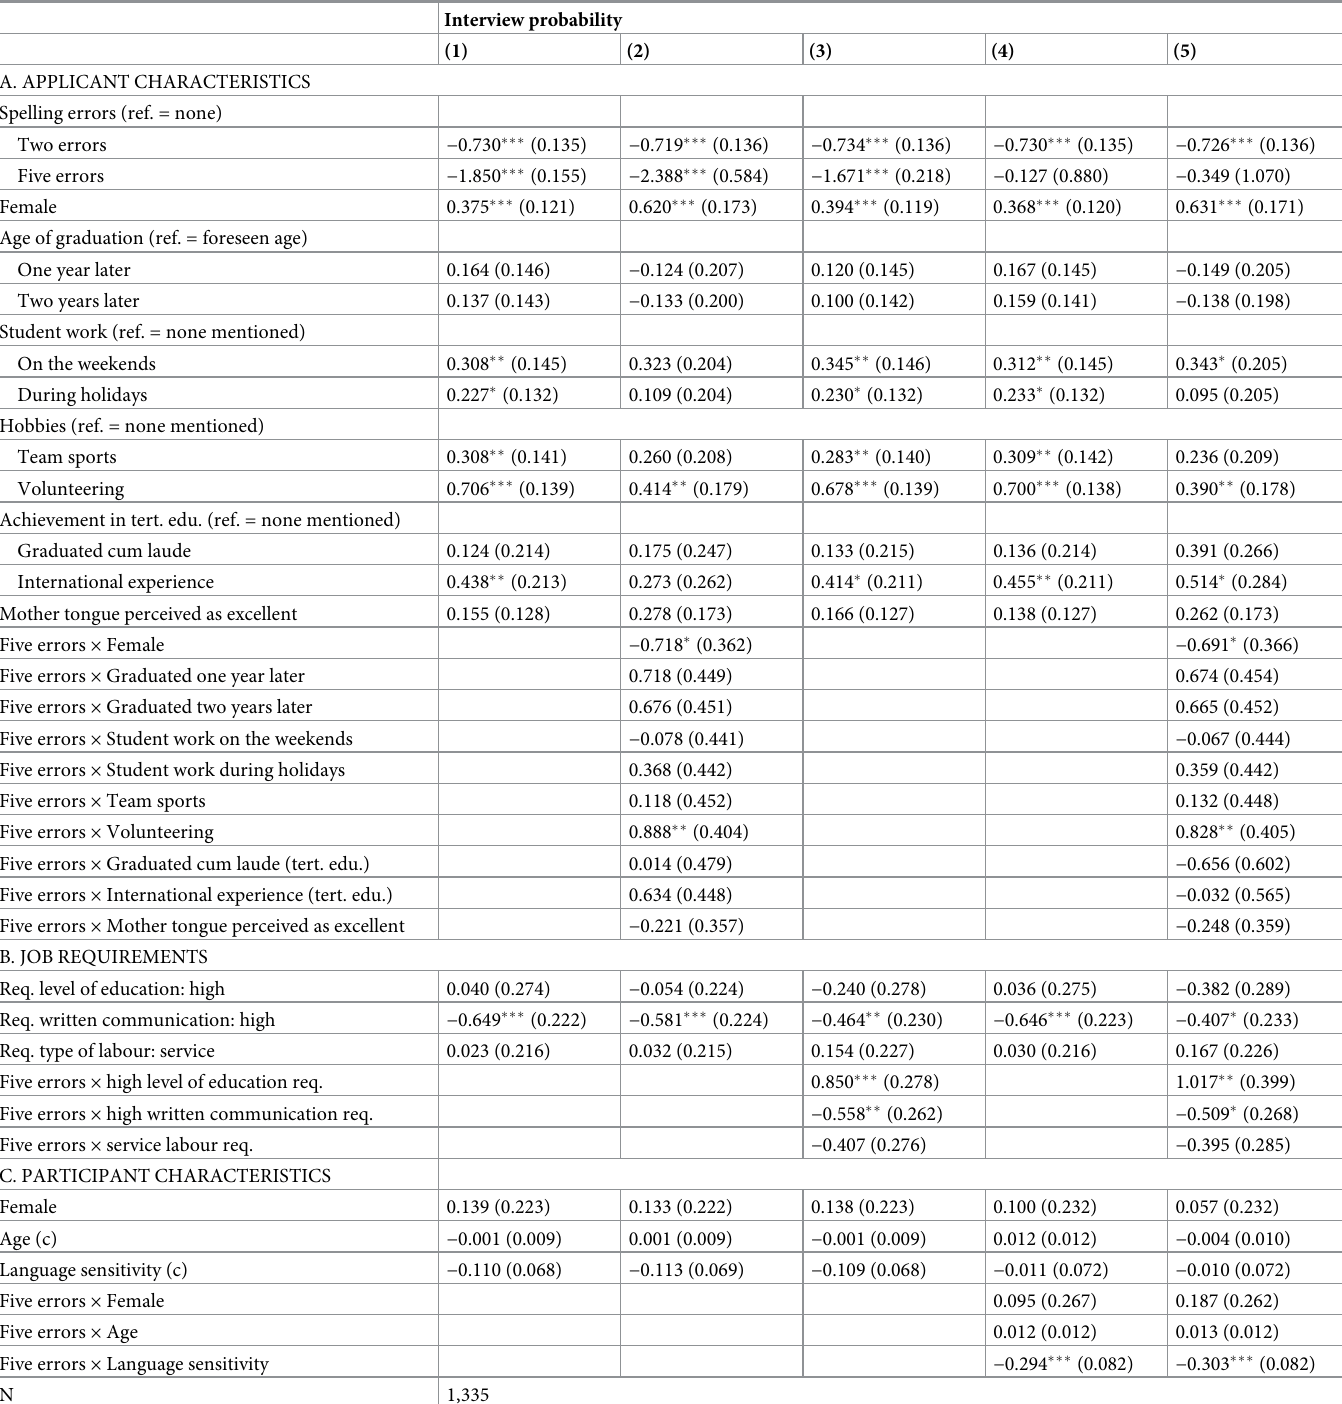
Table 4. Regression results with interview probability as the outcome variable, two-way interactions included for five spelling